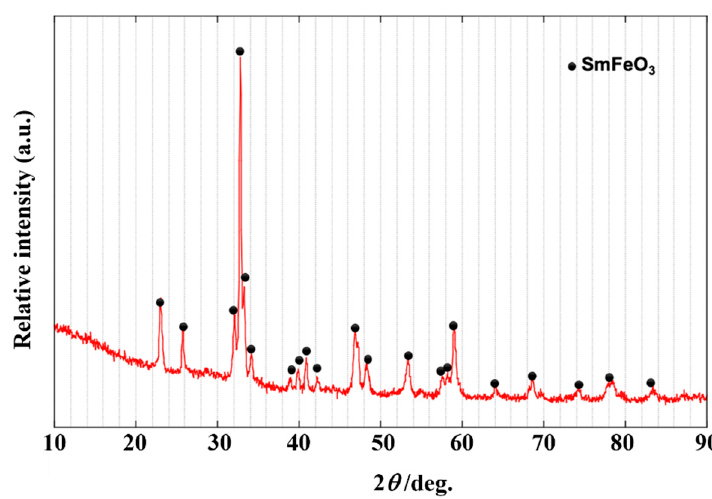
Figure 2. XRD patterns of the SmFeO 3 powder (sample A).